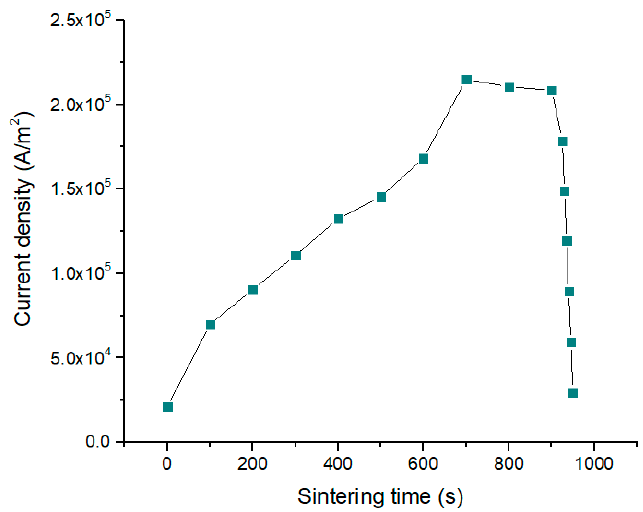
Figure 3. The dependence of current density on time that was used in the model with thermoelectric effect and contact resistance.